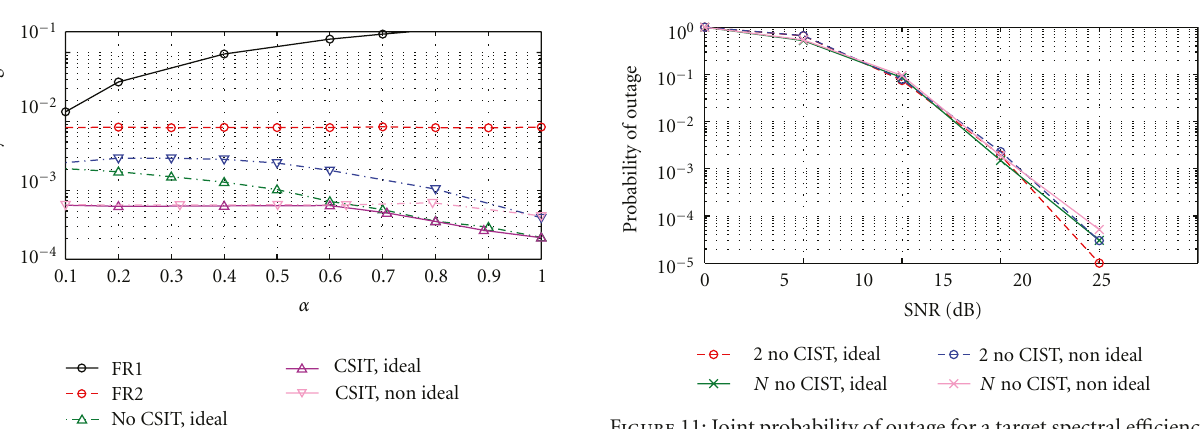
Figure 11: Joint probability of outage for a target spectral e ffi ciency R = 2bps/Hz, as a function of the SNR, for N = 10 base stations with 5 collaborating CFR pairs and N = 2 isolated BSs. α = 0 . 1.